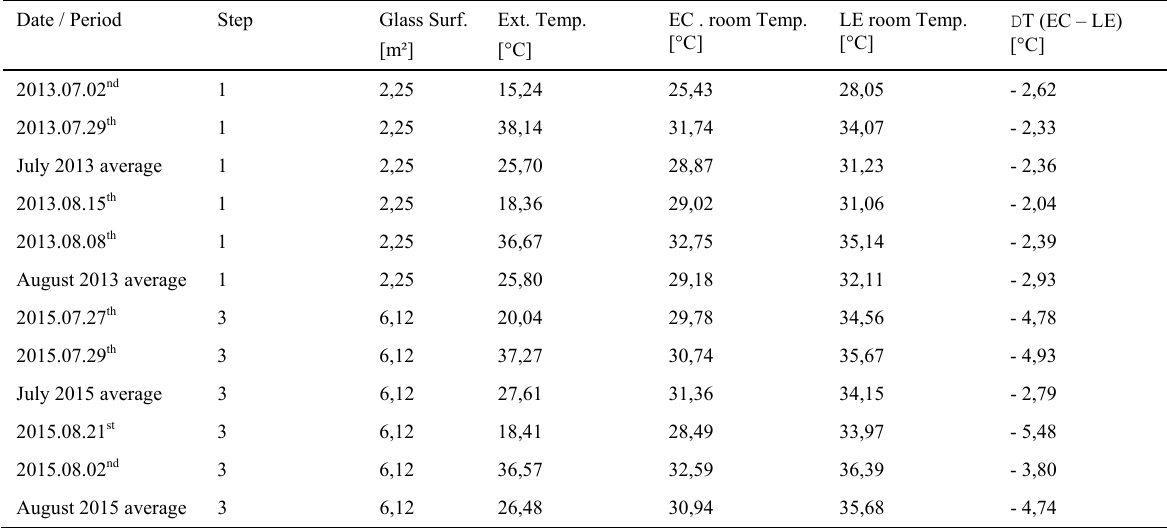
Table 2: Comparison Step 1 to Step 3 in the days in which the lowest and the highest averages were during the period in question. Date / Period Step Glass